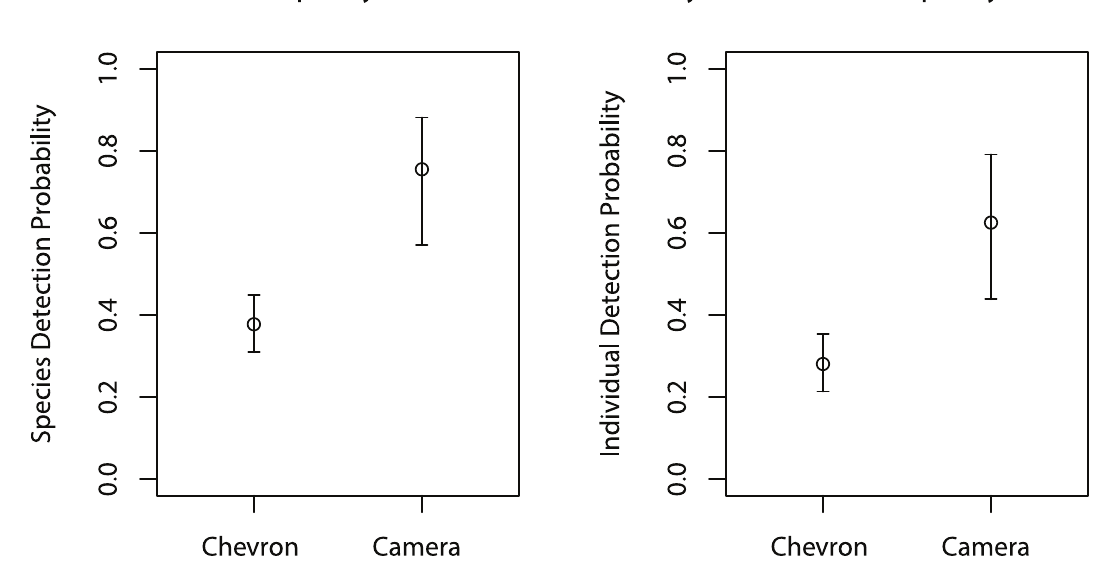
Figure 5. Mean chevron and camera trap detection probabilities. Estimated detection probabilities at the reference covariate values (intercept) from both the basic occupancy model (left panel) and the Royle-Nichols model (right panel) for red snapper. Note that for the basic occupancy model framework the detection probability is for the species at occupied sites. In contrast, for the Royle-Nichols framework the detection probability is for each individual at occupied sites. The intervals represent 95% credible intervals.